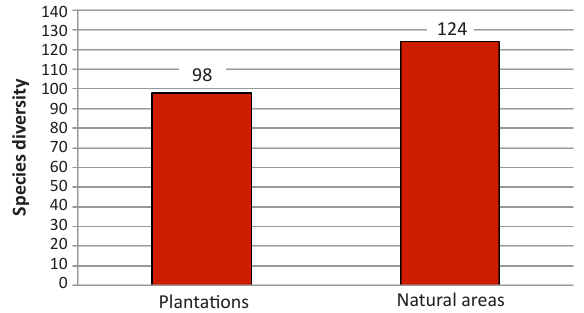
Figure 3. Butterfly species in the different habitats at Kerala Agricultural University